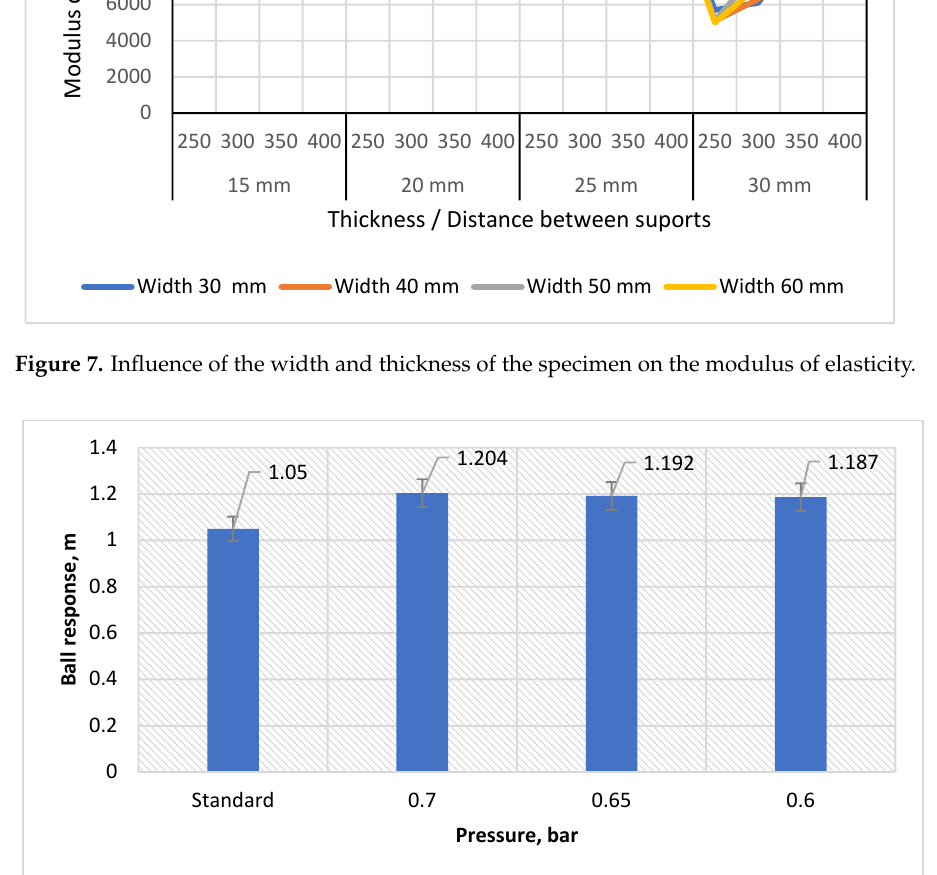
Figure 8. Values for the maximum bounce of the ball on the concrete surface at three different pressures in the ball.